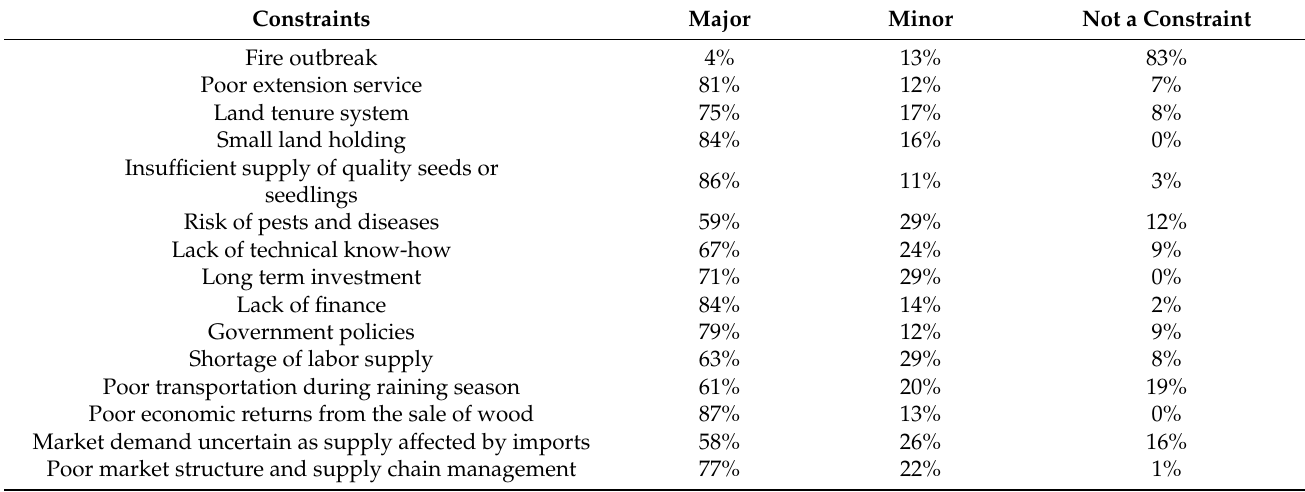
Table 5. Constraints Faced in Forest Plantation